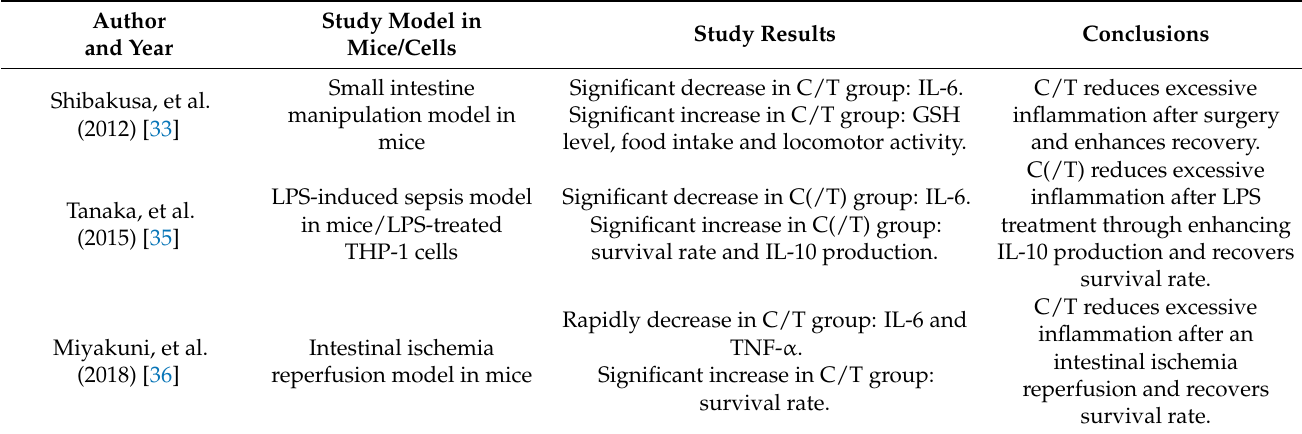
Table 2. Basic research of cystine/theanine for anti-inflammatory effects.